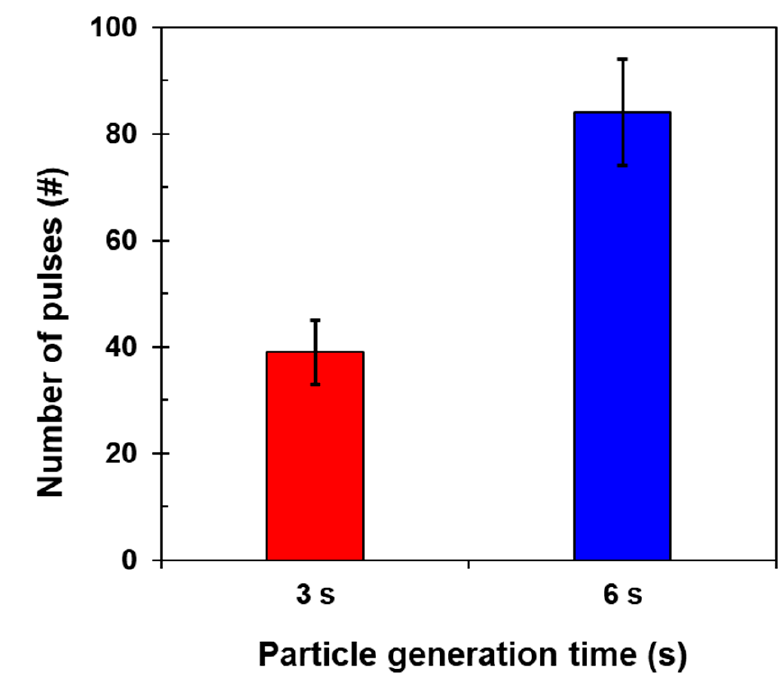
Figure 17. Number of capacitive pulses according to particle generation times (3 s and 6 s). Consequently, the proposed system can perform particle delivery and detection with continuous microcirculation. The proposed system is applicable in an environment where the MPs are generated randomly, to detect micro-sized (from 10 µ m to 40 µ m) airborne MPs on a real-time basis. It can be used at any site where on-site airborne MP monitoring is required (e.g., semiconductor package chambers and battery manufacturing